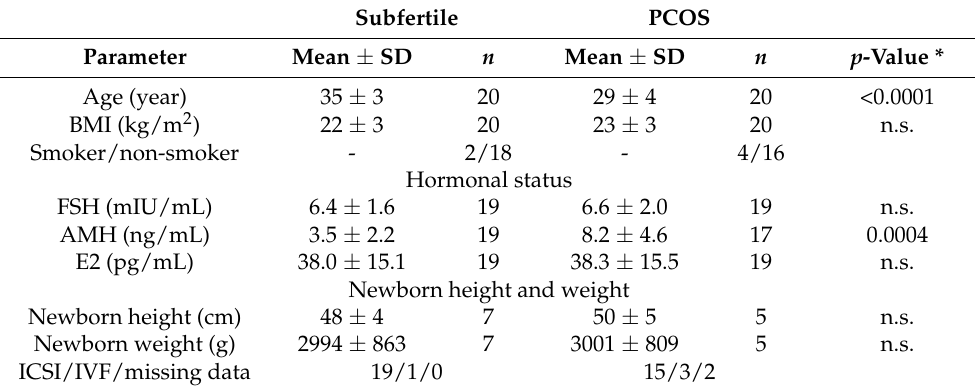
Table 1. Demographic and clinical characteristics of the women undergoing assisted